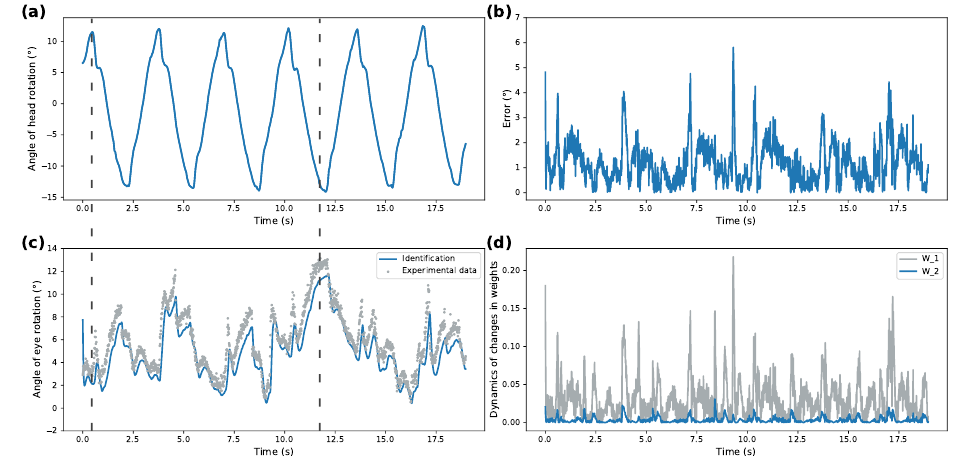
Figure 4. Identification with sigmoidal activation function for high-frequency rotations: ( a )—recorded head rotation; ( b )—identification error; ( c )—recorded data and identification results comparison; ( d )—evolution of